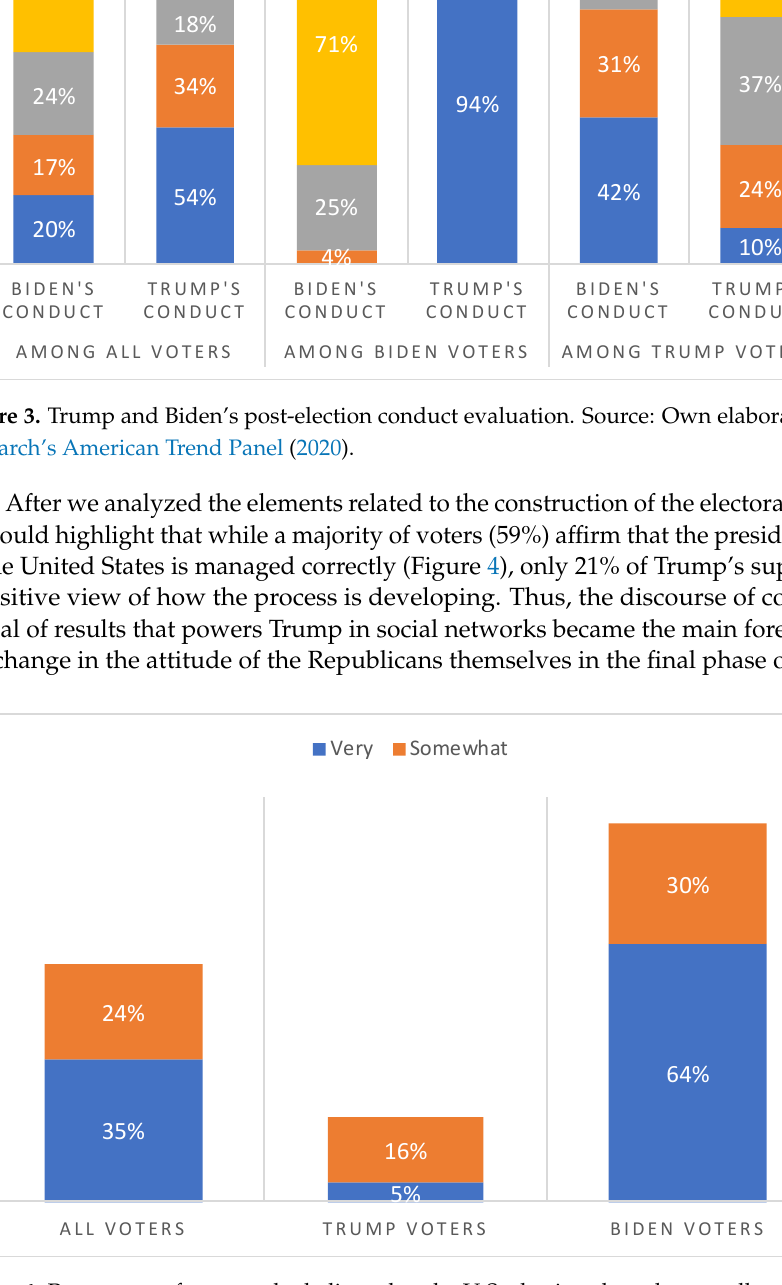
Figure 3. Trump and Biden’s post-election conduct evaluation. Source: Own elaboration from Pew Research’s American Trend Panel (2020).